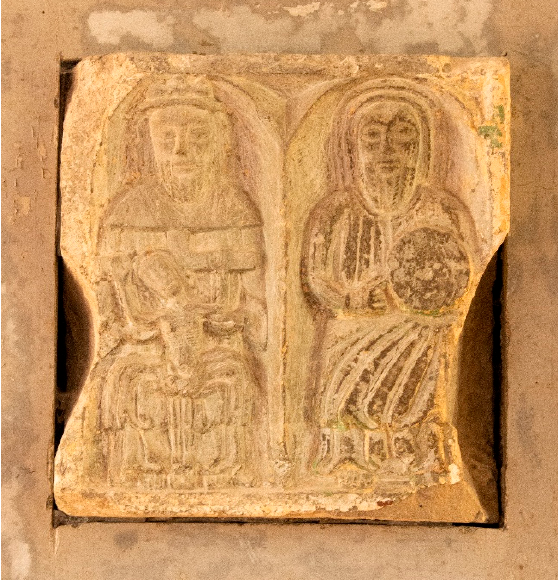
Figure 22. Throne of Grace, originally from a tomb sculpture in the Augustinian House of the Holy Trinity, Ballyboggan, now at the Church of the Assumption in Ballynabrackey, Co. Meath, early sixteenth century. Photograph by the author.